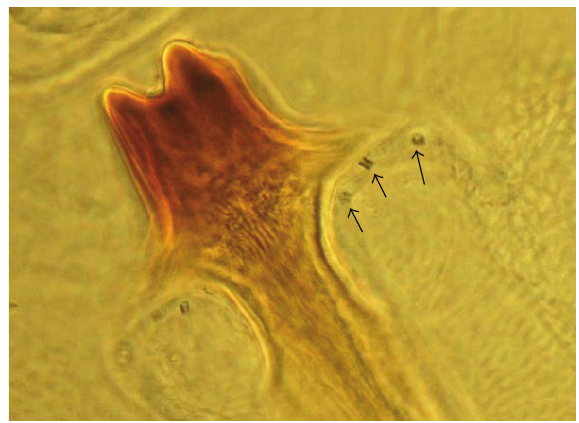
Figure 18: The fleshy pads attendant to the spatula have three sclerotized, socket-shaped papillae arrayed on their frontal margin (arrows).